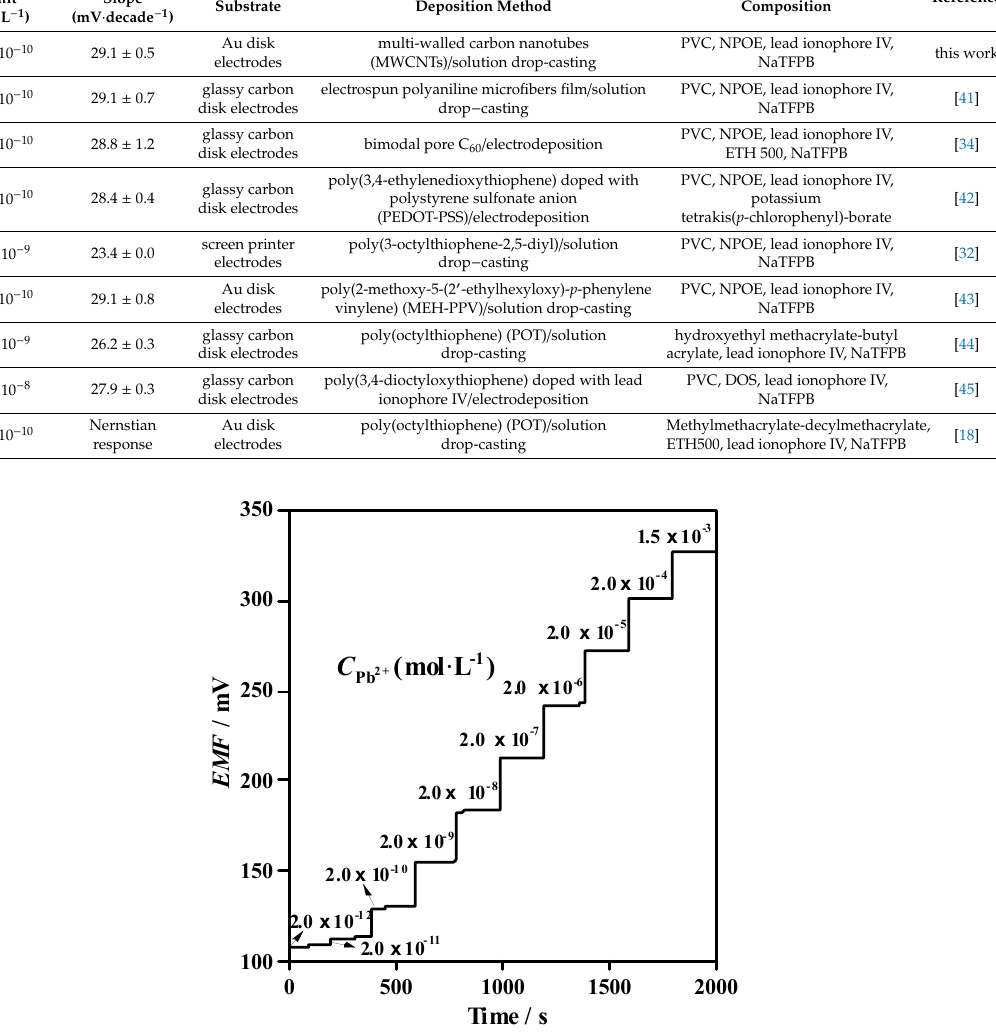
Figure 5. The response slopes profile for Pb 2+ ( ○ ) and interfering ions, including Na + ( * ), K + ( ◇ ), Ag + ( ☆ ), Cu 2+ ( ＋ ), Ca 2+ ( △ ), Mg 2+ ( × ), and Li + ( □ ). Figure 5 demonstrates the response slopes profile for different interfering ions in selectivity determination. It is clear that the sensitivity of the developed electrodes on Pb 2+ ( ○ ) is much higher than those of interfering ions, including Na + ( * ), K + ( ◇ ), Ca 2+ ( △ ), Mg 2+ ( × ), and Li + ( □ ). The proposed electrodes show a near ‐ Nernstian response of 57.1 ± 0.8 mV/decade over the Ag + concentration range from 2.0 × 10 − 8 to 2.0 × 10 − 3 mol ∙ L − 1 . With increasing concentrations from 2.0 × 10 − 5 to 2.0 × 10 − 3 mol ∙ L − 1 , the existence of Ag + ( ☆ ) would cause a slightly minor interference on the sensitivity for Pb 2+ . However, obvious interference is found from Cu 2+ ( ＋ ) below the Pb 2+ concentration of 2.0 × 10 − 6 mol ∙ L − 1 . In other words, at concentrations lower than 2.0 × 10 − 6 mol ∙ L − 1 , the sensitivity of the